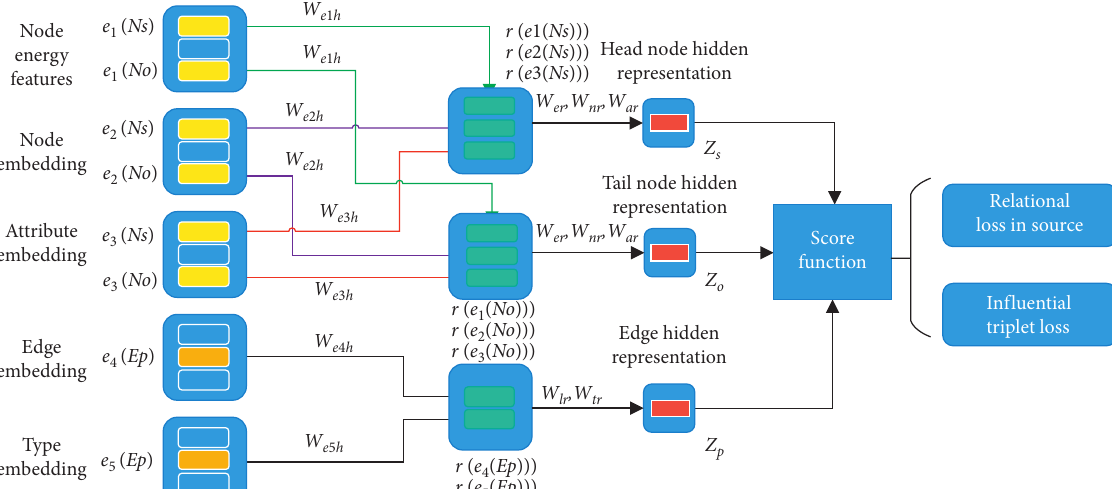
Figure 3: Detailed structure of neural network.